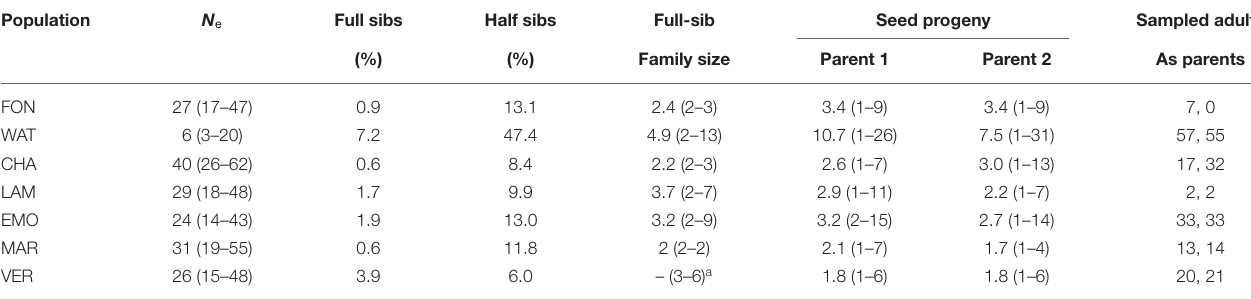
TABLE 3 | Effective population size ( N e , with 95% confidence intervals), sibship and parentage for seven populations of Campanula glomerata . Population N e Full sibs Half sibs Full-sib Seed progeny Sampled adults (%) (%) Family size Parent 1 Parent 2 As parents FON